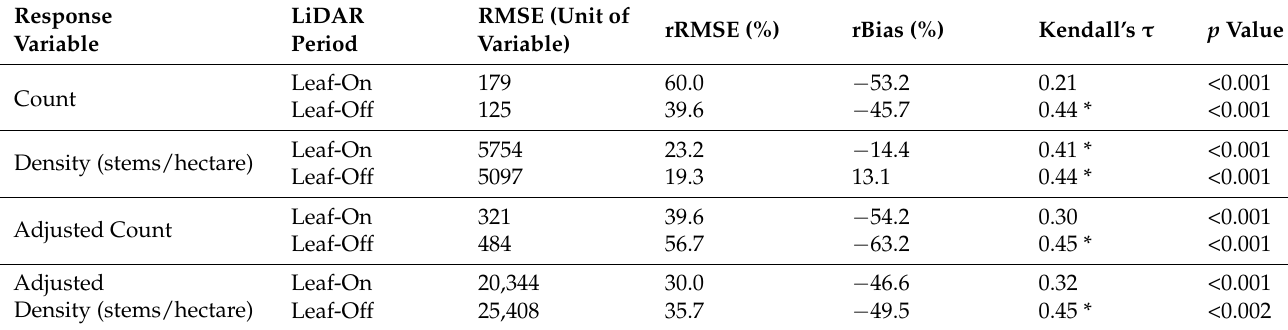
Table 2. Root-mean-square error (RMSE), relative RMSE (rRMSE), relative bias (rBias), Kendall’s τ correlation values, and p values from pairwise comparisons for the various density measurements derived from LiDAR point clouds collected in leaf-on and leaf-off campaigns compared to ground data. Adjusted values were calculated by adding the counted shrubs ( ≥ 1.3 m) to the tree values in the ground